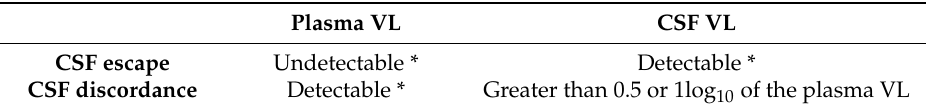
Table 1. Definition of CSF escape and CSF discordance. * Depending on the limit of quantification of the assay used. Usually 50 copies/mL. VL; Viral